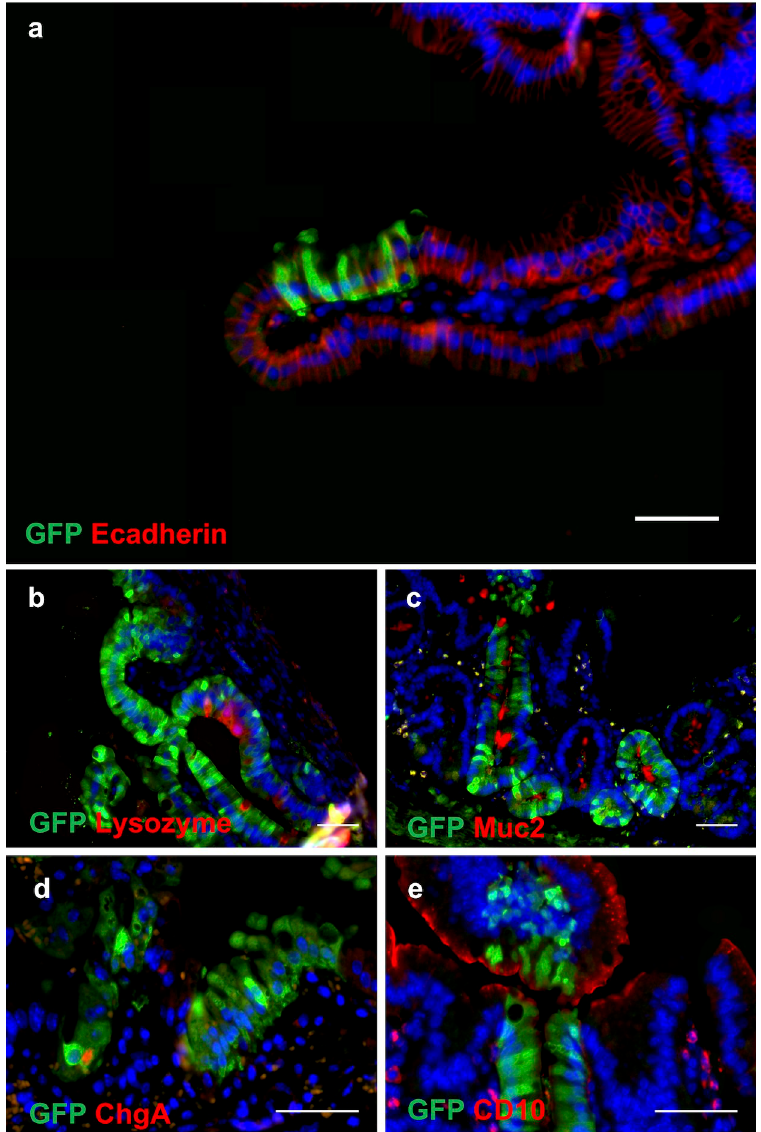
Fig 5. Immunofluorescence stains of engrafted human GFP spheroids in the small intestine on post-implantation week 1 . (a) E-cadherin, (b) lysozyme, (c) Muc2, (d) chromogranin A and (e) CD10. Nuclei are counterstained blue with DAPI. Scale bars, 50 μ